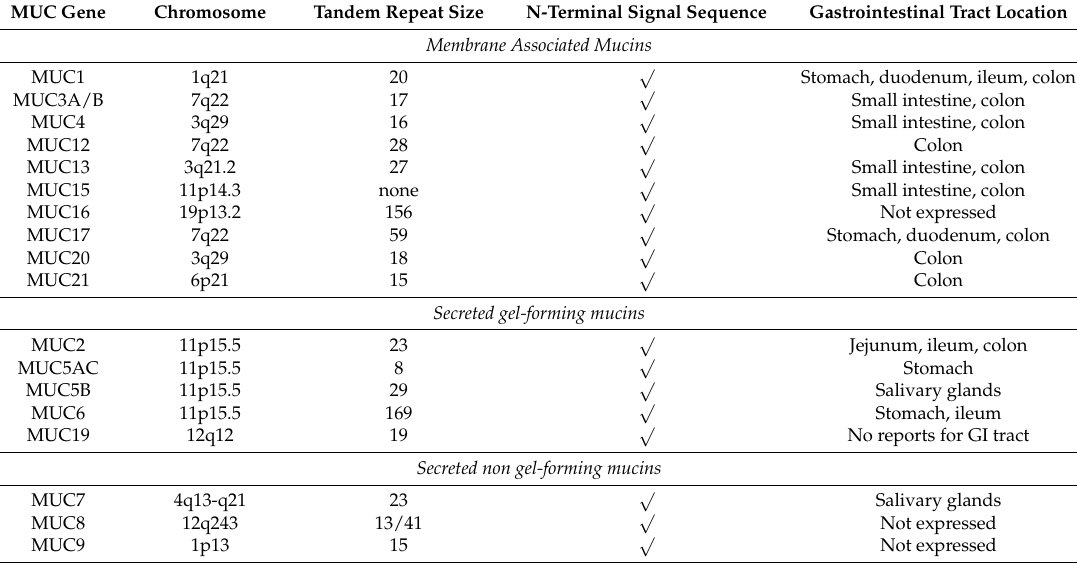
Table 1. The Mucin (MUC) Gene Family.